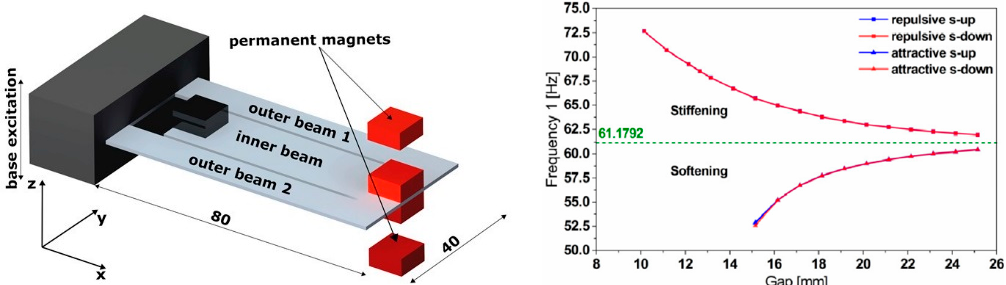
Figure 4. Descriptive scheme of the dual-frequency mechanical resonator ( left ) with experimental results illustrating the 12% bi-directional frequency shift considering the outer part tuning ( right